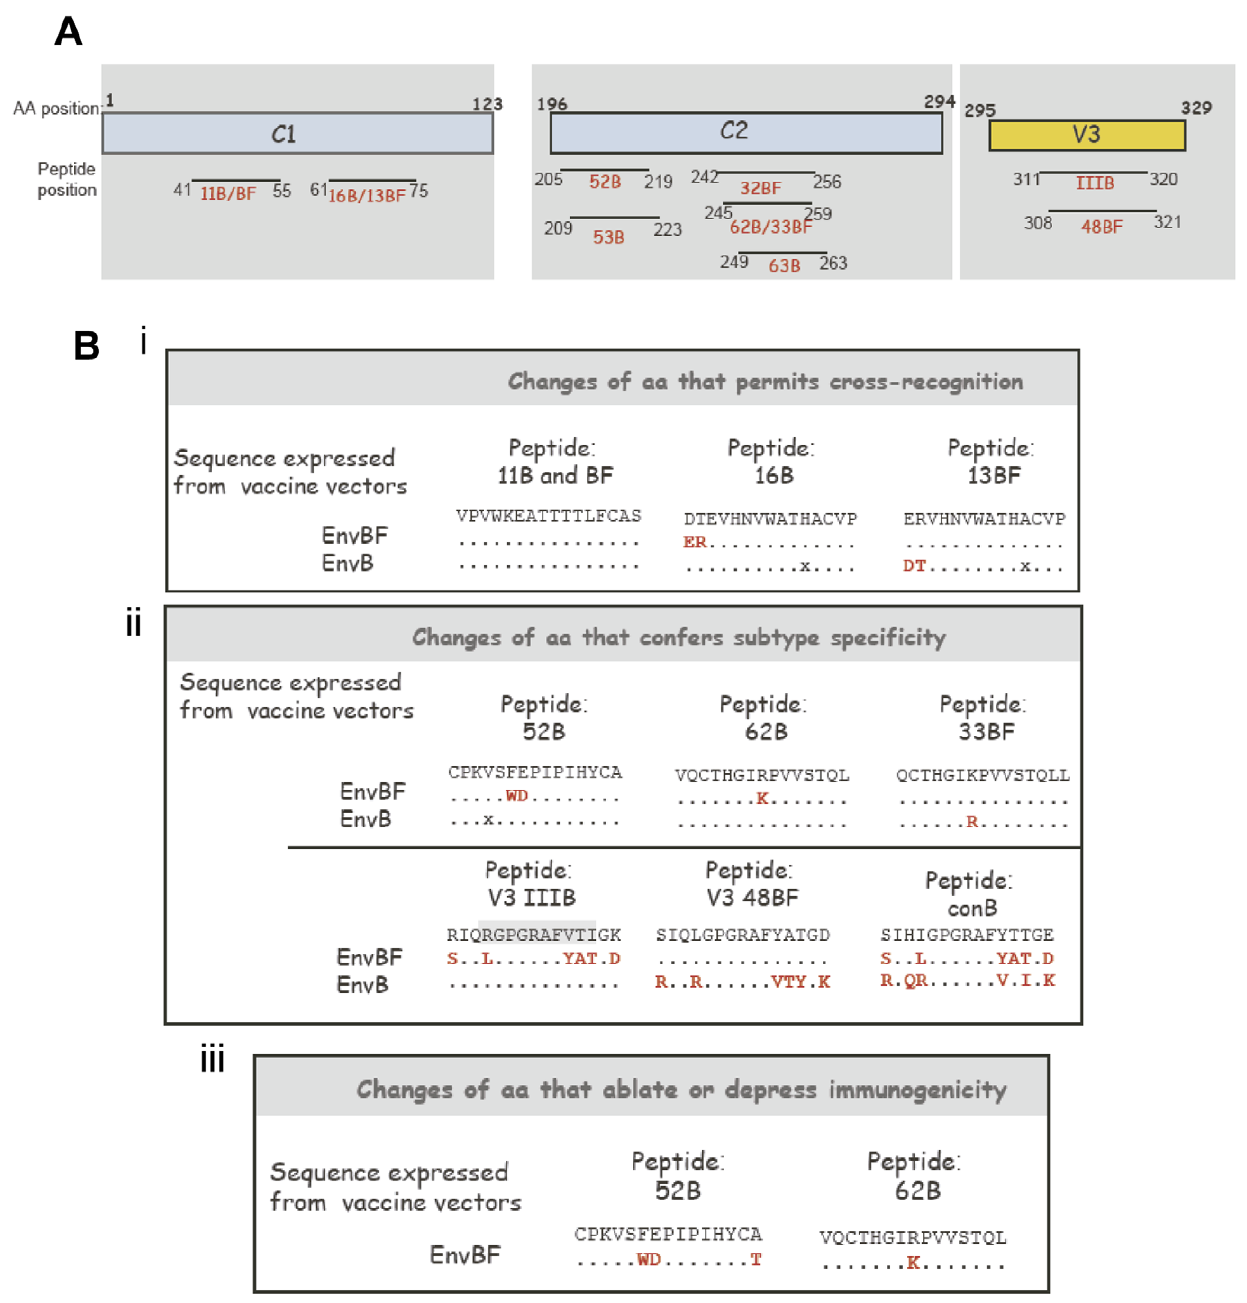
Figure 5. Analysis of the sequences and localization of the B and BF peptides targeted. A ) Scheme showing the different Env regions and localization of the B and BF peptides targeted after the EnvB and EnvBF immunizations B ) Description of the aa sequence of the peptides recognized and of the sequence expressed from the vectors Description of the aa changes that permits cross-recognition i), that confer suptype specificity ii) and of the changes that ablates or depress immunogenicity iii) An x indicates that for that position a different aa is encoded from the DNAenvB